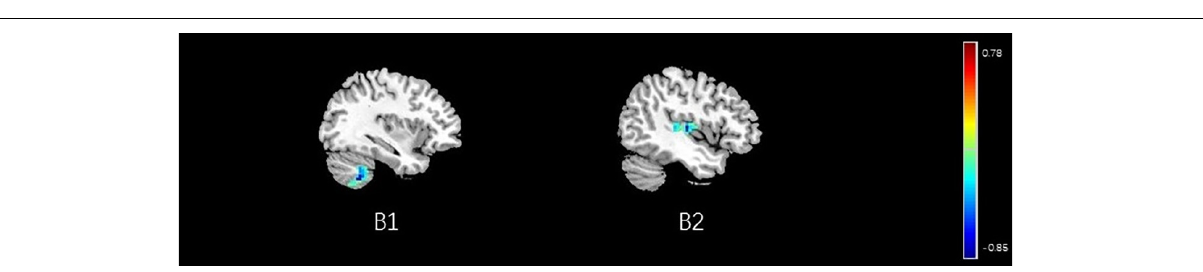
FIGURE 13 | Regions showing significant correlation with the pain score of placebo response in male participants. Color scale represents the correlation coefficient. Red = positive correlation; blue = negative correlation. B1: cerebellum posterior lobe, B2: insular.